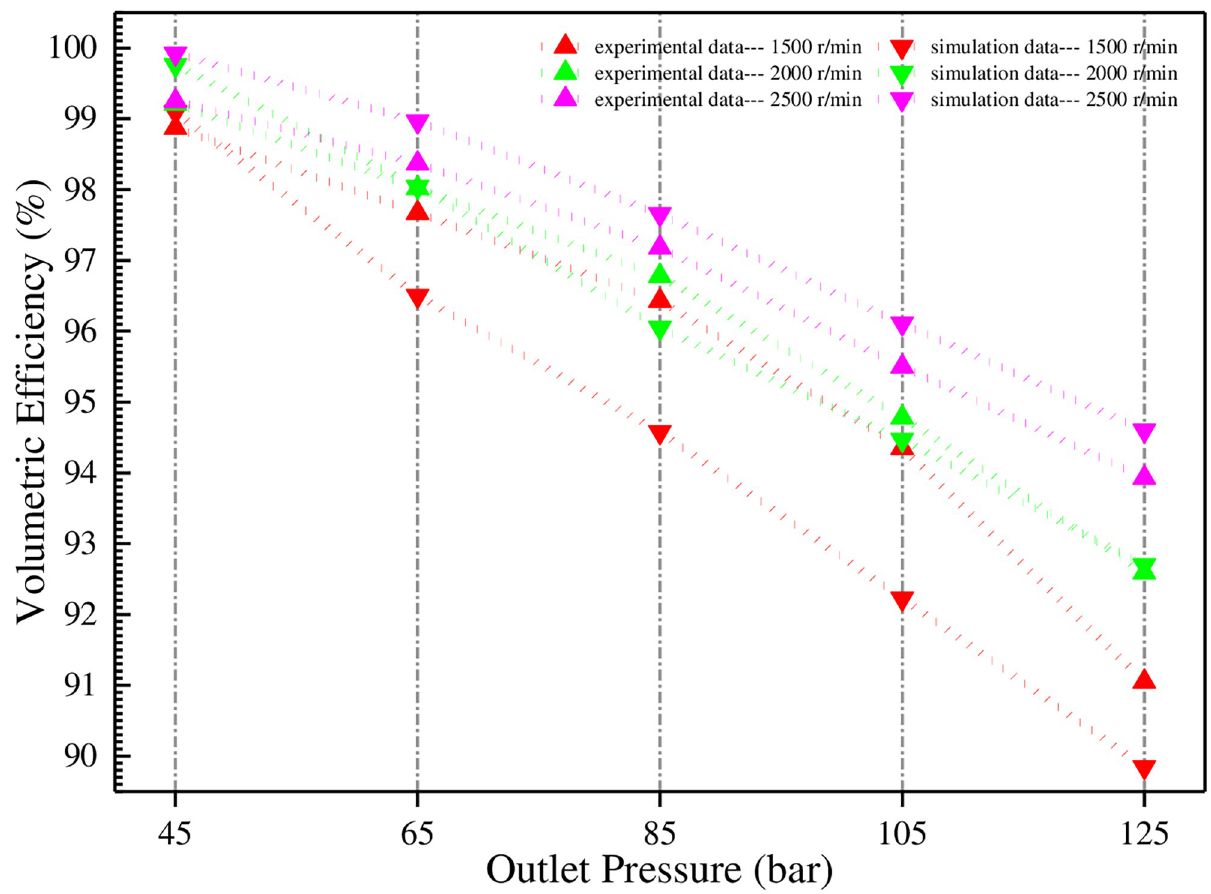
Fig 22. Comparison of experimental and simulated volumetric efficiencies under variable working conditions.